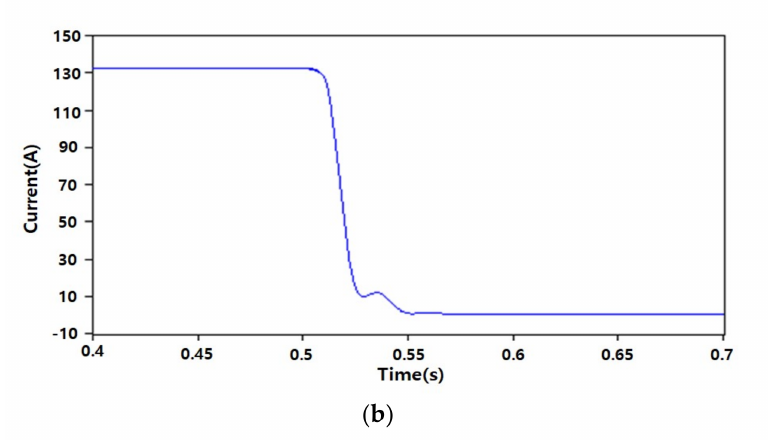
Figure 15. Simulation results of Case 3: ( a ) Fault section and CB operation and ( b ) Load current.